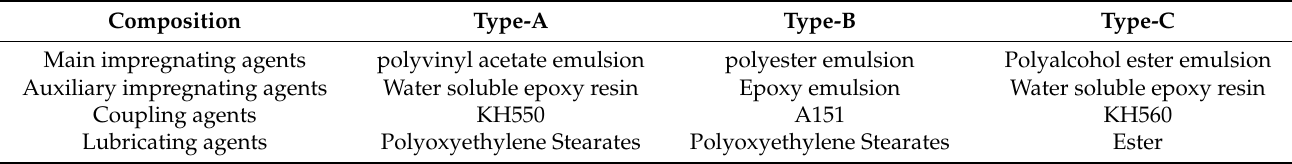
Table 3. Composition of three kinds of basalt fiber impregnating